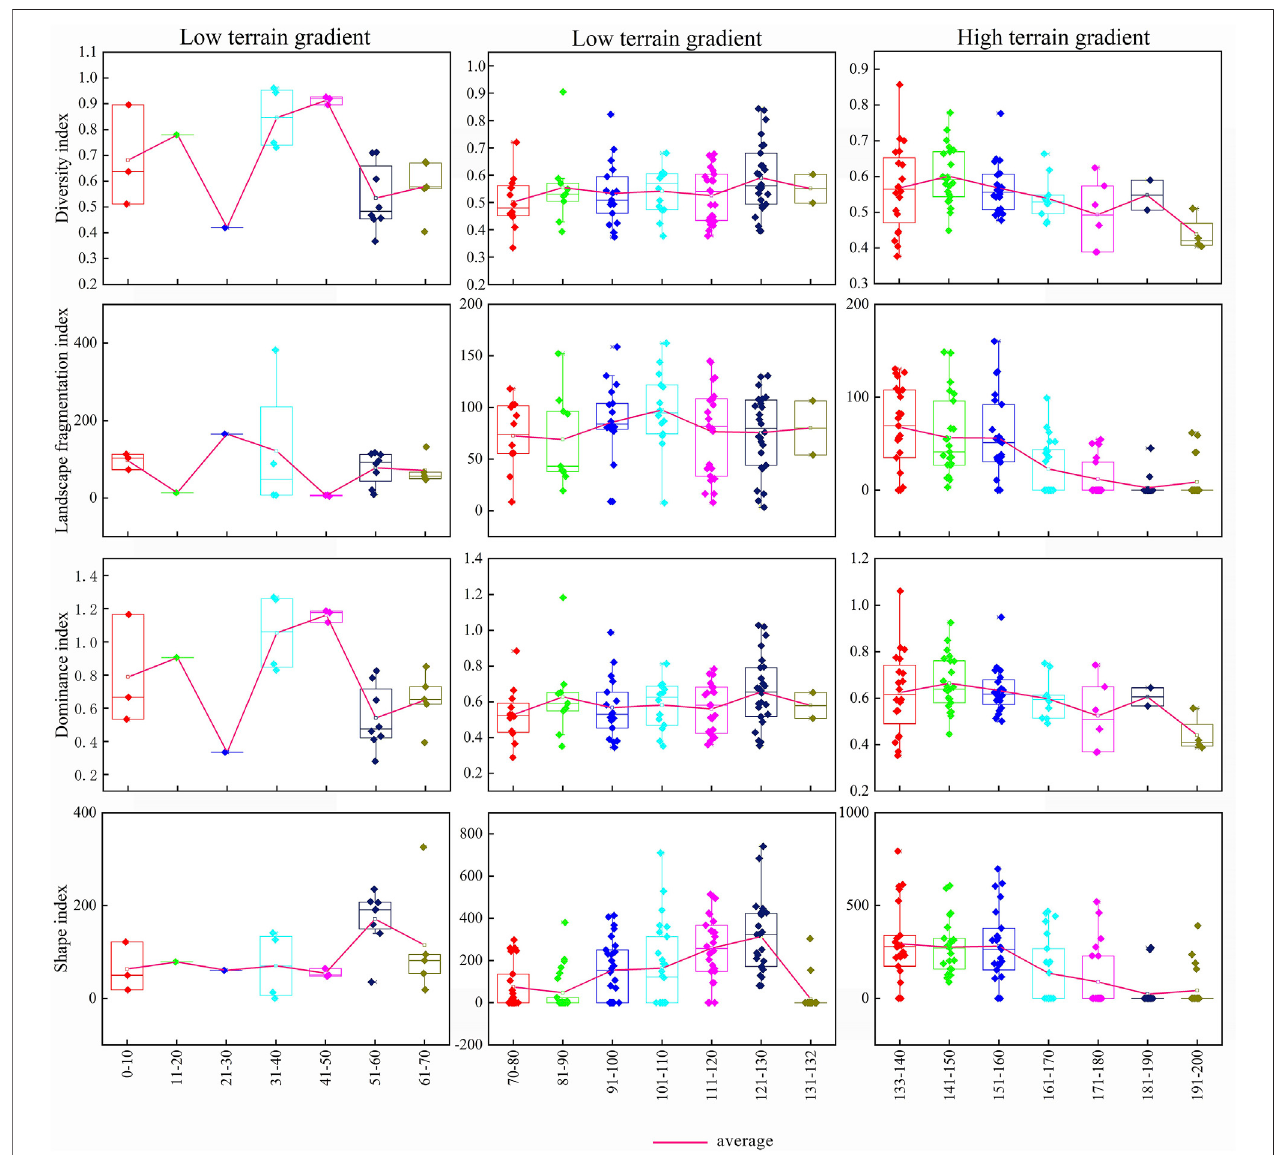
FIGURE 6 | Topographic gradient differentiation map of the landscape index of